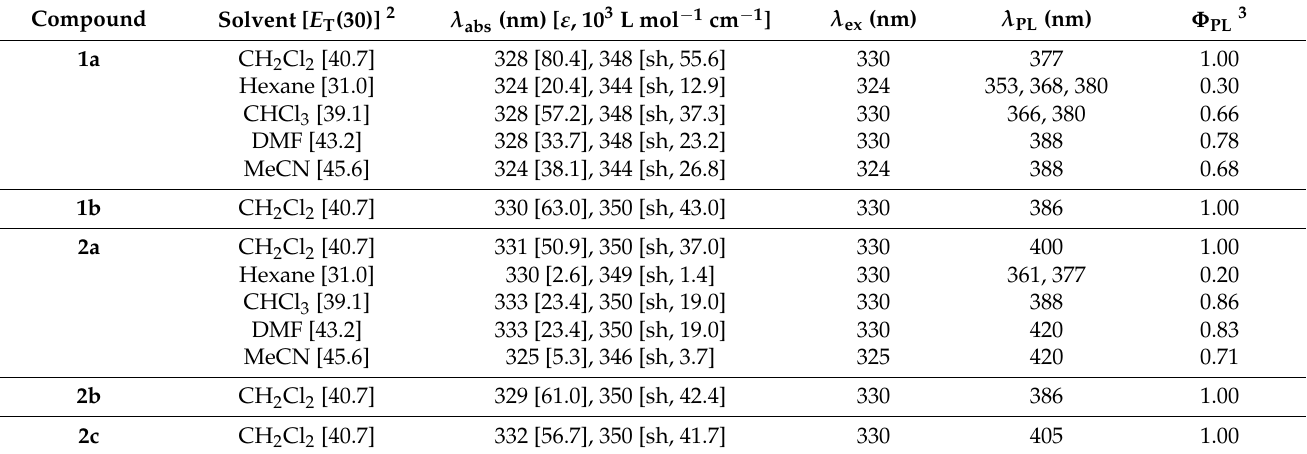
E T (30) value is a quantitative indicator of the solvent polarity. 3 Measured using an integrating sphere; sh: shoulder